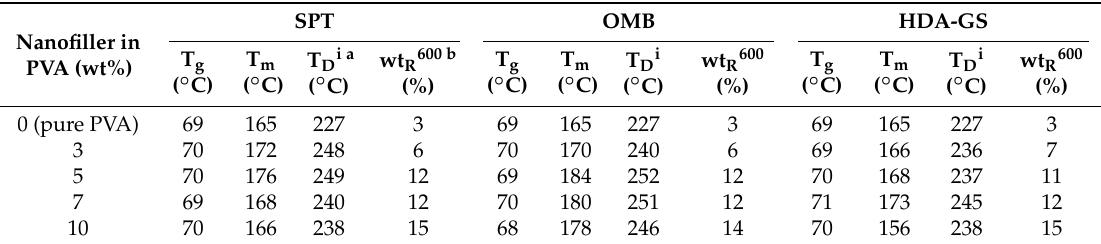
Table 1. Thermal properties of PVA hybrid films with various nano-filler contents. Nanofiller